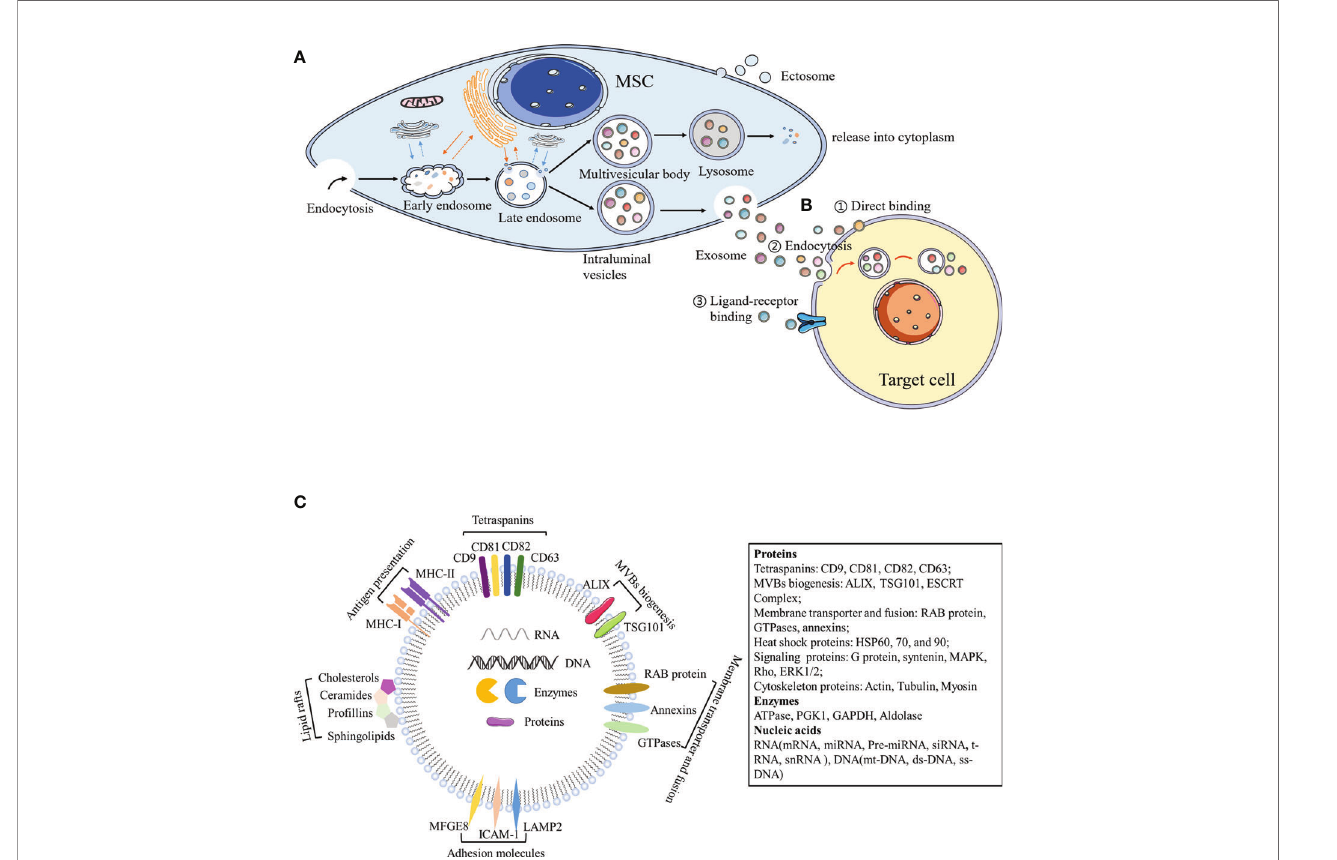
FIGURE 1 | Biogenesis and components of exosomes. (A) Exosomes originate from the endosomal pathway. Extracellular material enters the cytoplasm through plasma membrane depression and endocytosis, and fuses with early endosomes, endoplasmic reticulum and preformed Golgi bodies, to develop into late endosomes, which are interlinked with the cell membrane network structure to form ILVs containing a vesicle structure. Different concentrations and sizes of ILVs constitute MVBs. On the one hand, MVBs fuse with lysosomes, degrade the contents, and release them into the cytoplasm. On the other hand, MVBs are transferred to the cytoplasmic membrane through the membrane system and vesicles are released outside the cell, which are termed exosomes. (B) Exosomes can act by binding to receptors present on the surface of target cells, by binding to endocytosis, or by the direct binding to recipient cells. (C) Exosome components. MFGE8, milk fat globule-EGF factor 8 protein; ICAM-1, intercellular adhesion molecule 1; MHC I and II, major histocompatibility complex I and II; LAMP2, lysosomal- associated membrane protein 2; MAPK, mitogen-activated protein kinase; ERK, extracellular signal-regulated kinase; PGK1, phosphoglycerate kinase 1; GAPDH, glyceraldehyde 3-phosphate